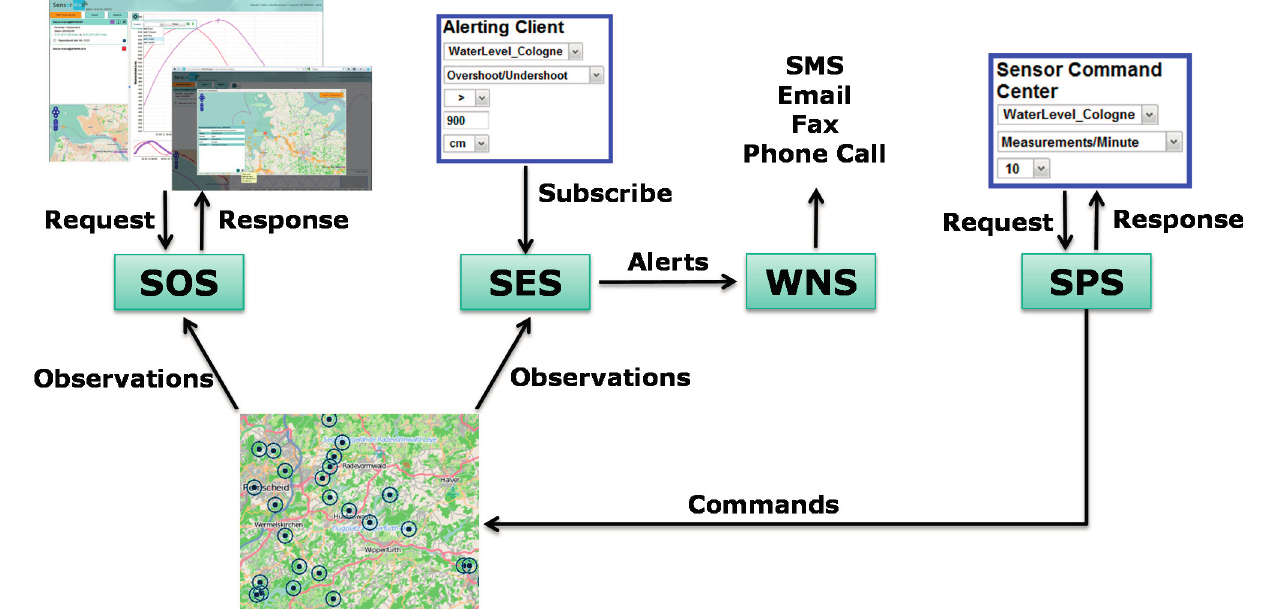
Figure 1. Stack of standards part of the OGC Sensor Web